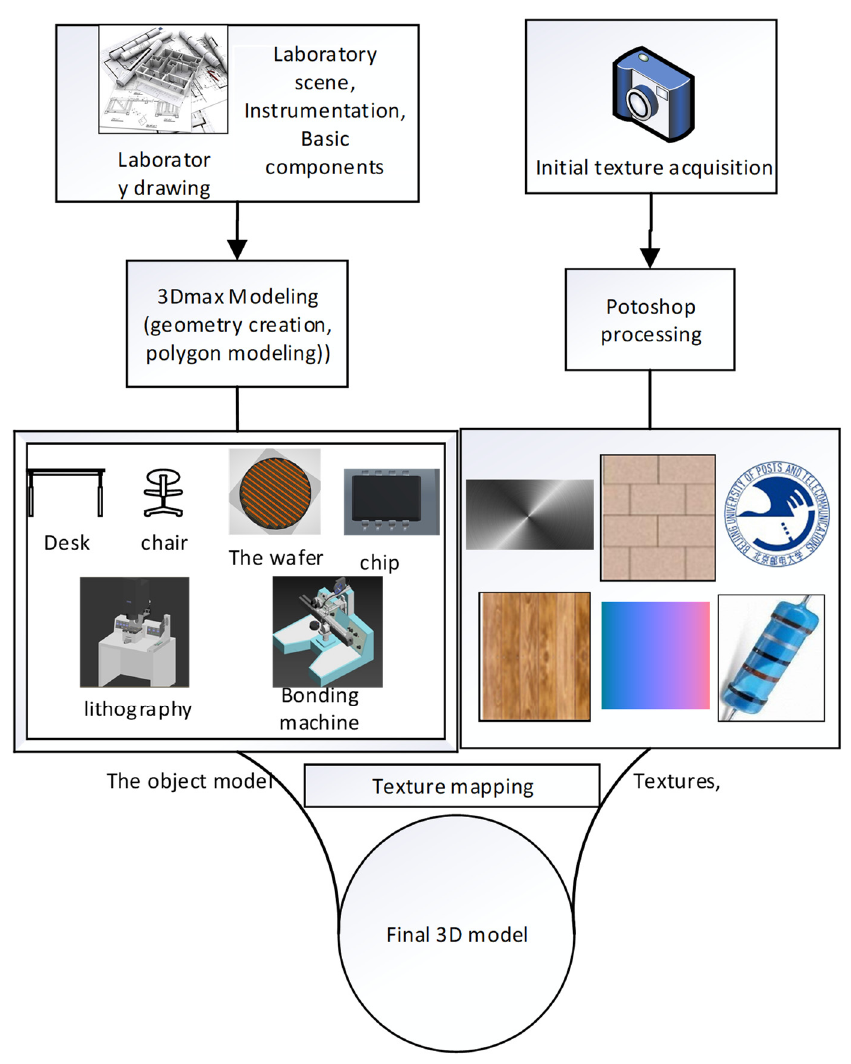
Figure 4. Production process of laboratory 3D scene.